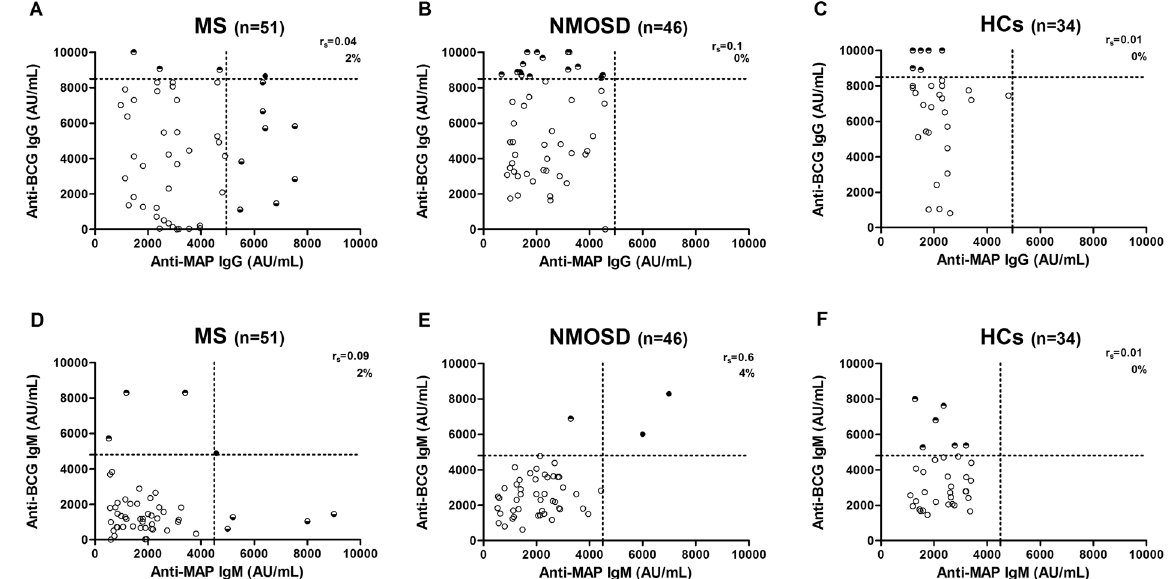
Figure 3. Correlation analysis. Correlation between Abs recognizing anti-MAP and anti-BCG specific IgG in MS ( A ), NMOSD ( B ) and HCs ( C ); and Abs recognizing anti-MAP and anti-BCG specific IgM in MS ( D ), NMOSD ( E ) and HCs ( F ). Each filled black circle represents the titer of a patient with double positivity for MAP and BCG Abs, while each half-filled circle represents the titer of a patients with specie-specific Abs. Empty circles are Ab-negative patients. The dotted line lines designate the cutoff for positivity used in each assay, as calculated by ROC